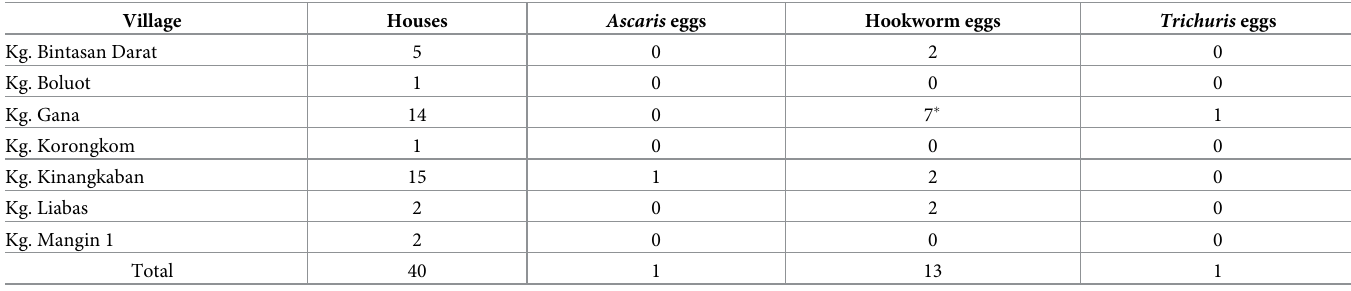
Table 10. Detection of geohelminth stages from soil samples. Samples were taken from the compound of 40 households whose children’s faecal samples had tested posi- tive for worms.